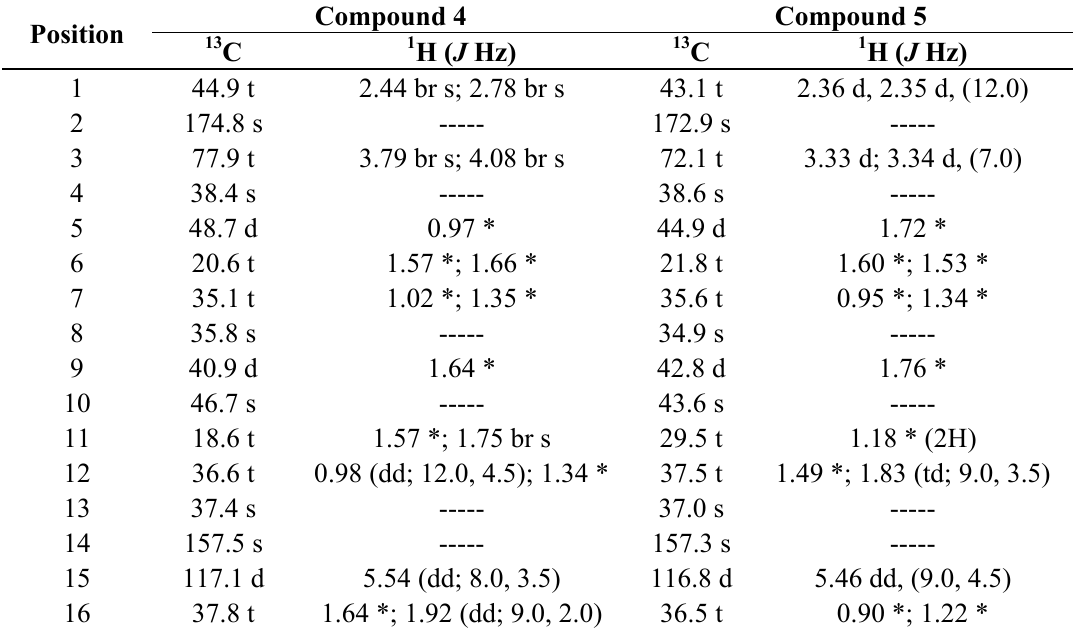
Table 1. ¹H/¹³C-NMR data of 4 (CDCl parenthesis in